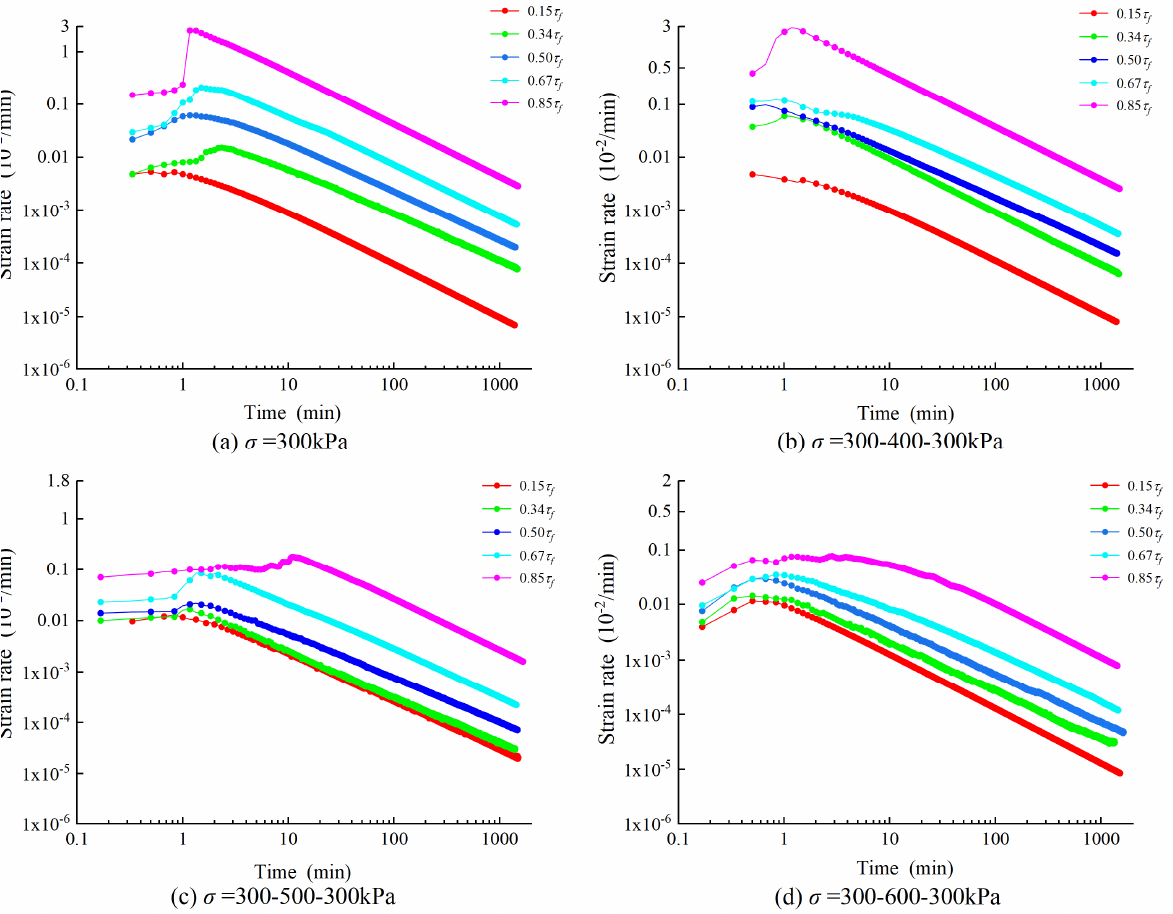
Figure 10. Strain rate–time curve with different consolidation paths.